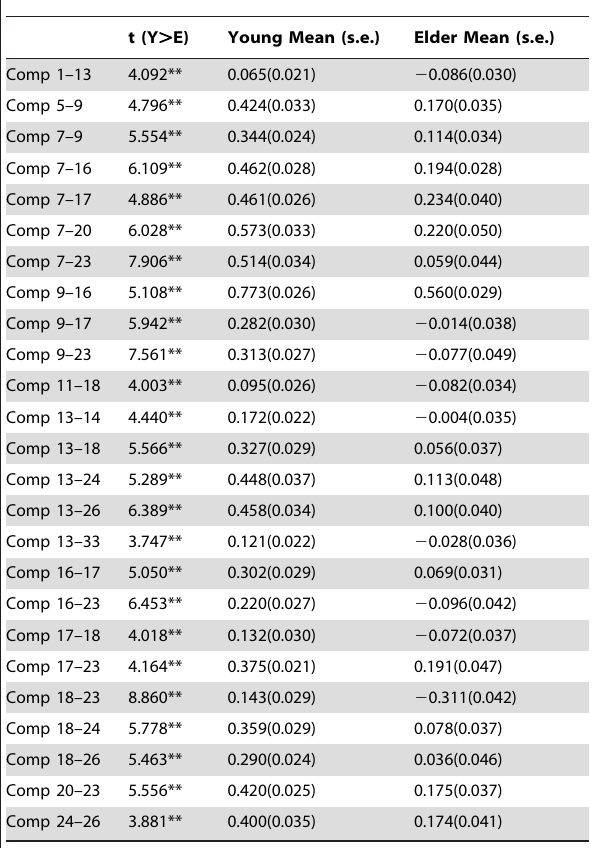
Table 4. T-test results for group differences in strength of functional network connectivity between components and the mean and standard errors for each